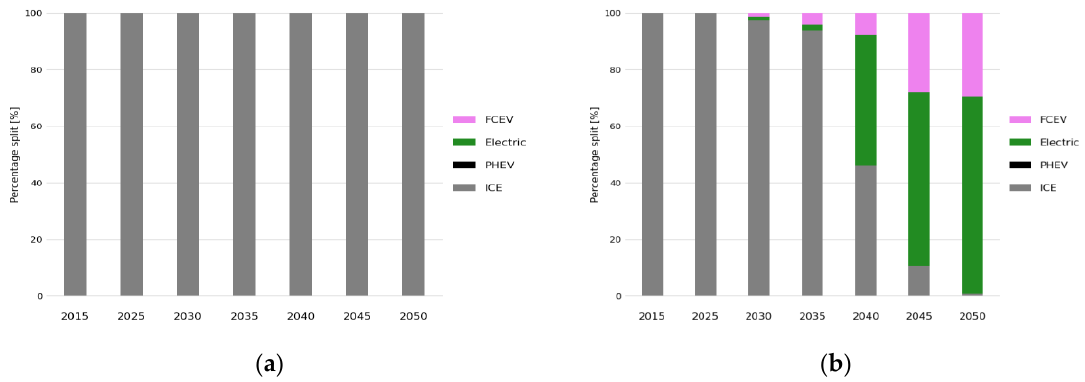
Figure 8. Freight road vehicle mix over time for different scenarios (represented in terms of share in total ton–km travelled by each vehicle technology type): ( a ) LME; ( b ) P1.5